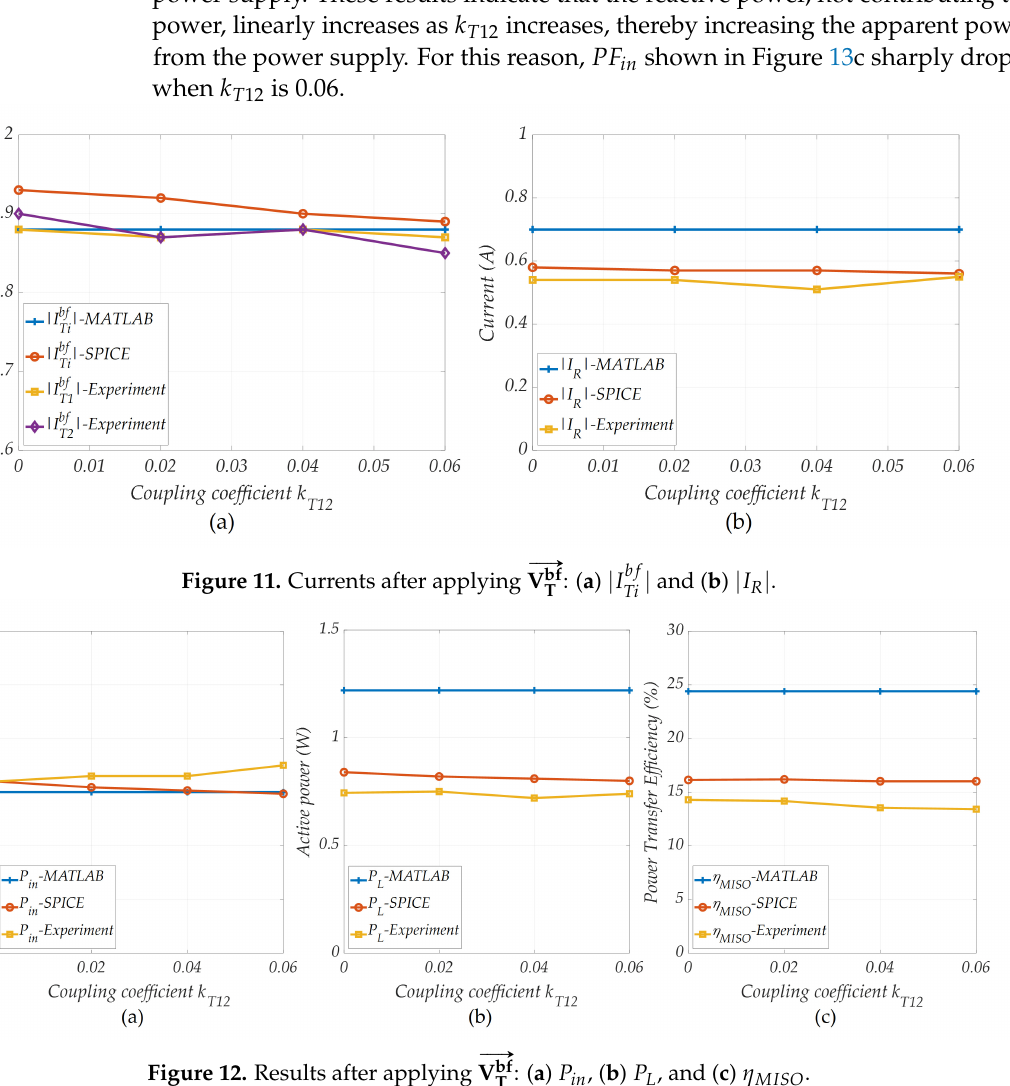
Figure 12. Results after